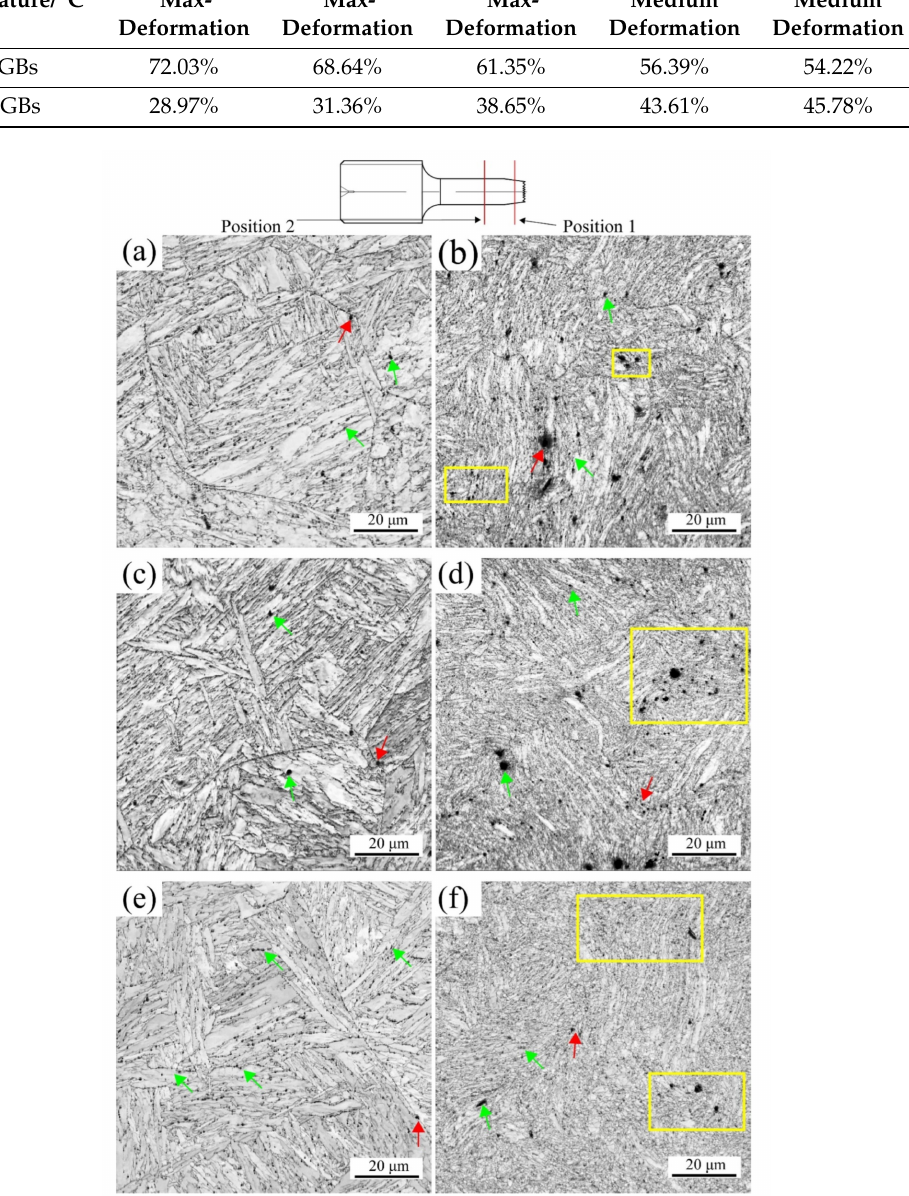
Figure 6. IQ maps for different degrees of deformation at RT ( a , b ); 430 ◦ C ( c , d ); and 630 ◦ C ( e , f ), where the red arrows refer to voids along the PAGBs, and the green arrows represent voids along the boundaries of the